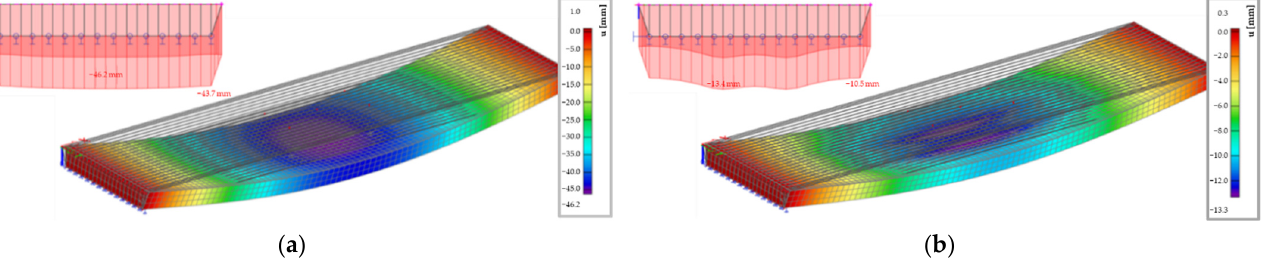
Figure 2. Longitudinal and transverse deflection under ( a ) a uniformly distributed load (LC3) and ( b ) a service vehicle (LC4).